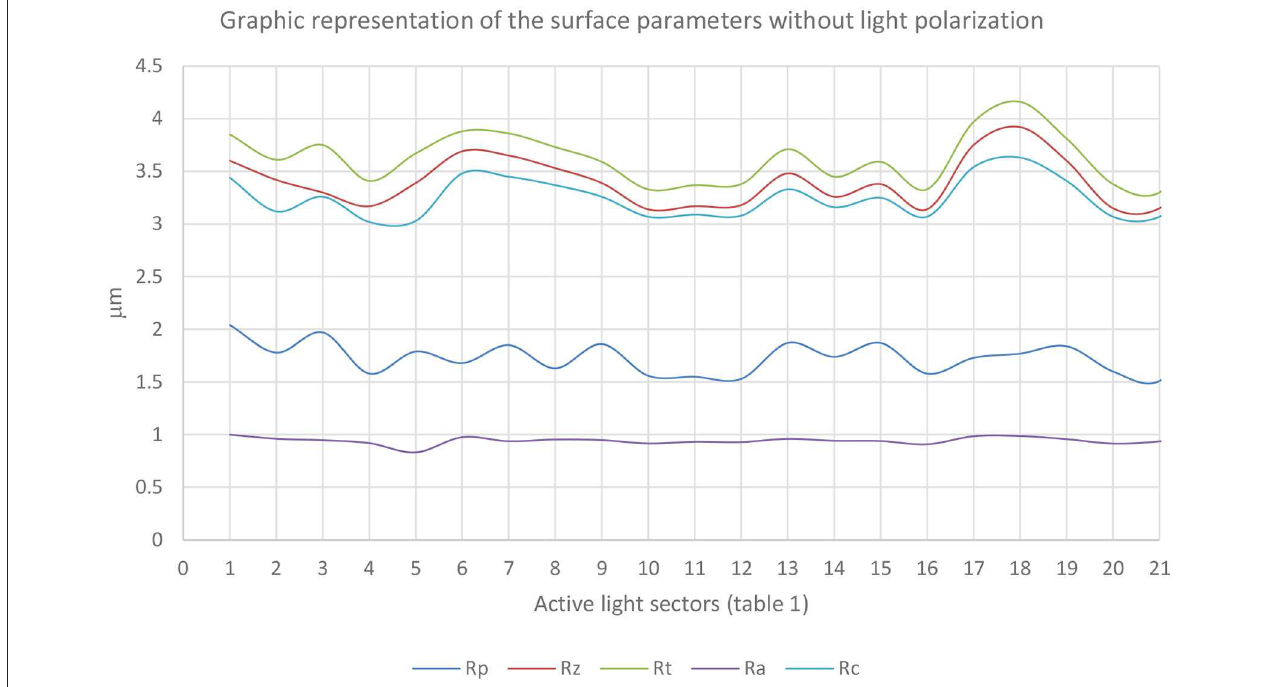
FIGURE 7 | Graphic representation of the surface parameters without light polarization depending on active light sectors.